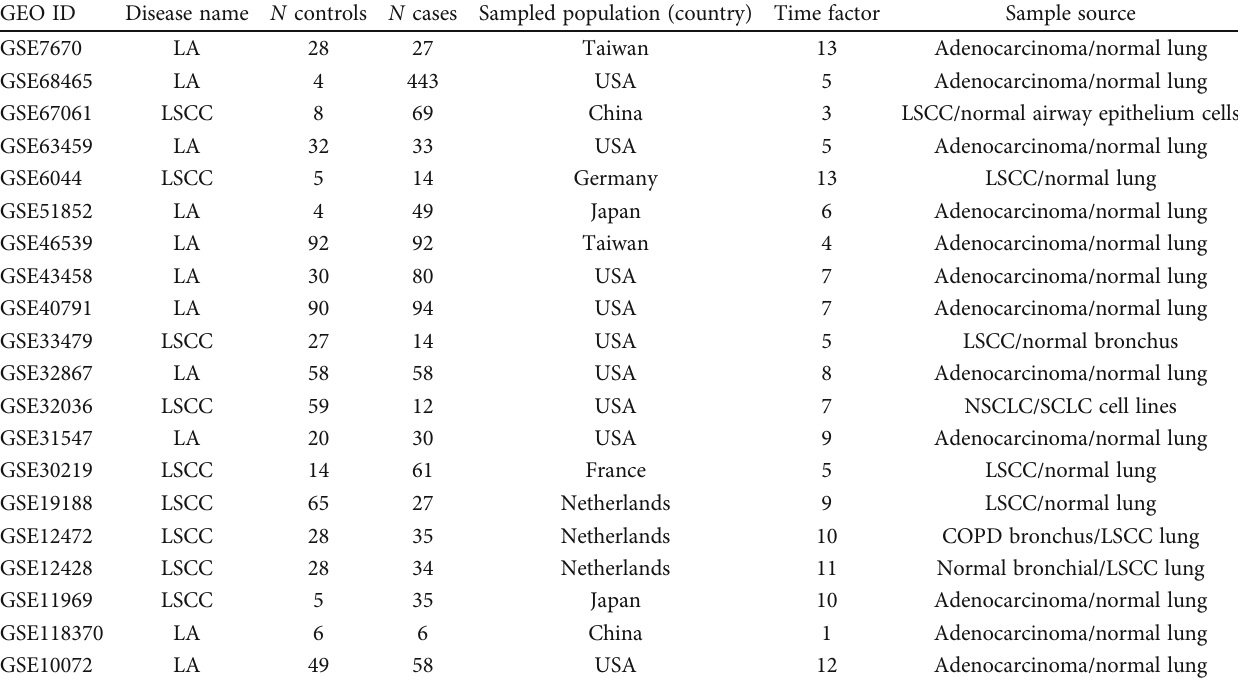
Table 1: Key descriptors of 20 LA/LSCC RNA expression datasets selected for this study. GEO